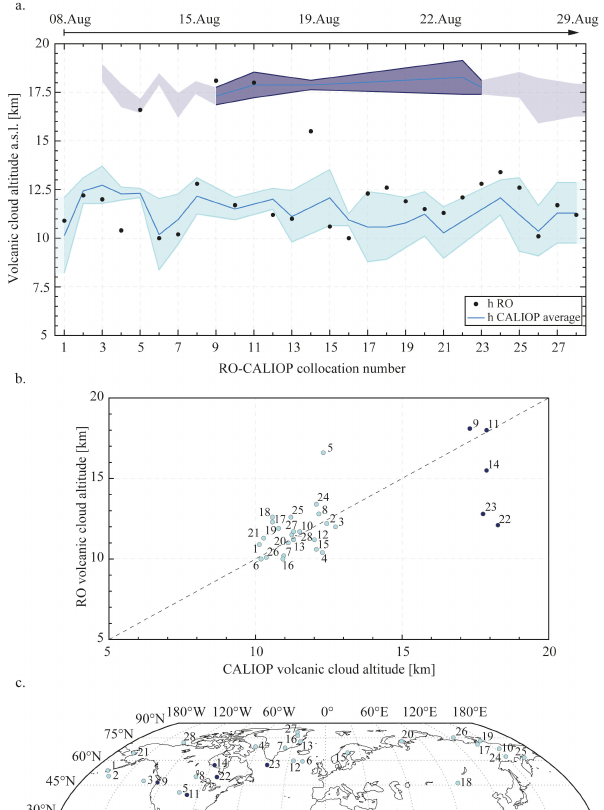
Figure 2. ( a ) Plot showing on the y-axis the volcanic cloud (VC) altitude in km a.s.l. detected from the radio occultation (RO) BA anomaly profiles peaks (black dots) compared to the average VC altitude estimated from Cloud-Aerosol Lidar with Orthogonal Polarization (CALIOP) backscatter (blue line). The shaded areas correspond to the top, and bottom altitude of the two layers of VC estimated from the collocated backscatter. Only in the upper layer, the light gray extremes represent estimations on backscatter that is not collocated with any RO profile but was acquired around the same time window. On the x-axis, the RO-CALIOP collocation number in chronological order, see arrow above for the temporal indication. ( b ) Scatter plot between the VC altitude estimated from the RO BA anomaly (y-axis) and CALIOP backscatter (average values, x-axis). ( c ) Map showing the spatial distribution of the collocated RO profiles. In both ( b ) and ( c ) the same color code and number sequence of plot ( a )